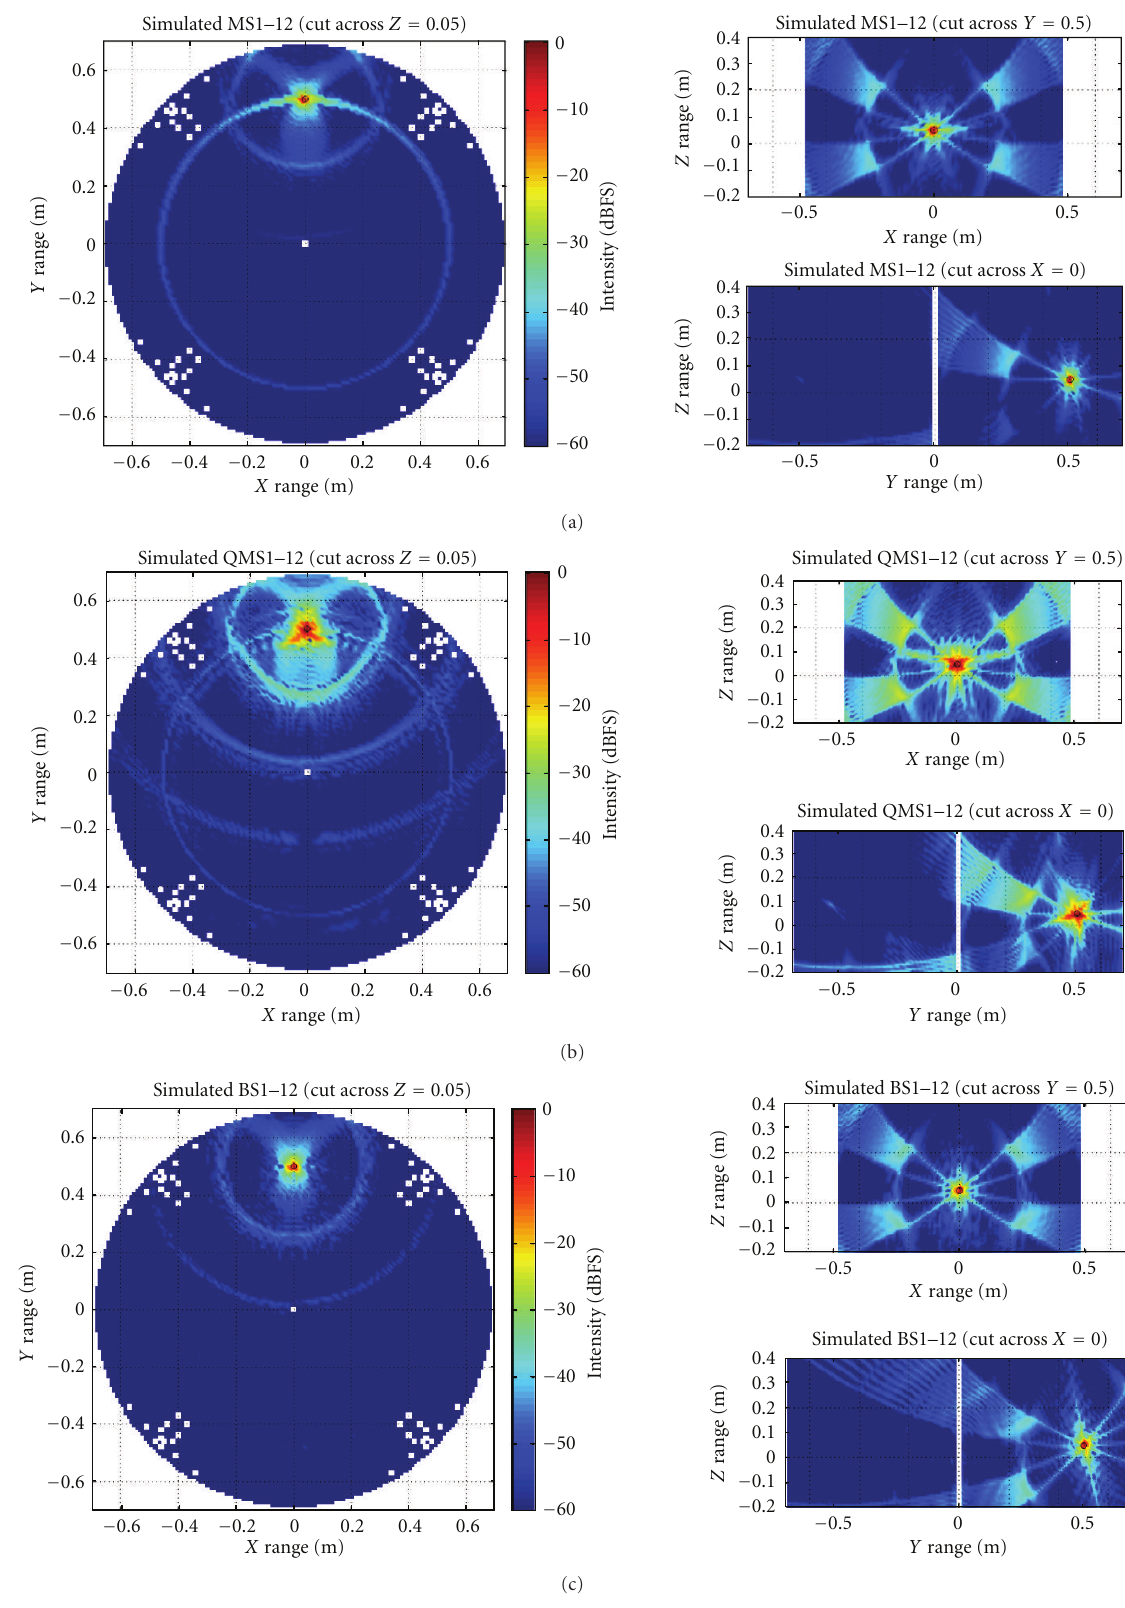
Figure 17: Simulated point-spread-function results for a single target at [ X , Y , Z ] = [0,0 . 5,0 . 05] cut through each plane. (a) (Q)MS antennas, (Q)MS algorithm. (b) BS antennas, (Q)MS algorithm. (c): BS antennas, BS